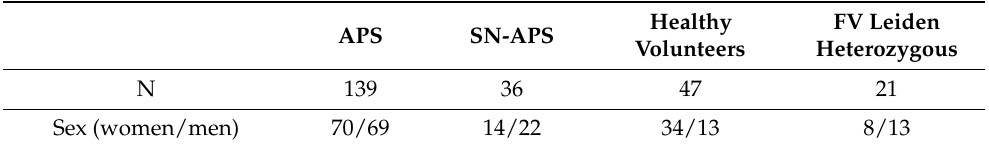
Table 1. Overview of population in the examined patient cohort. APS: antiphospholipid syndrome. SN-APS: seronegative antiphospholipid syndrome.